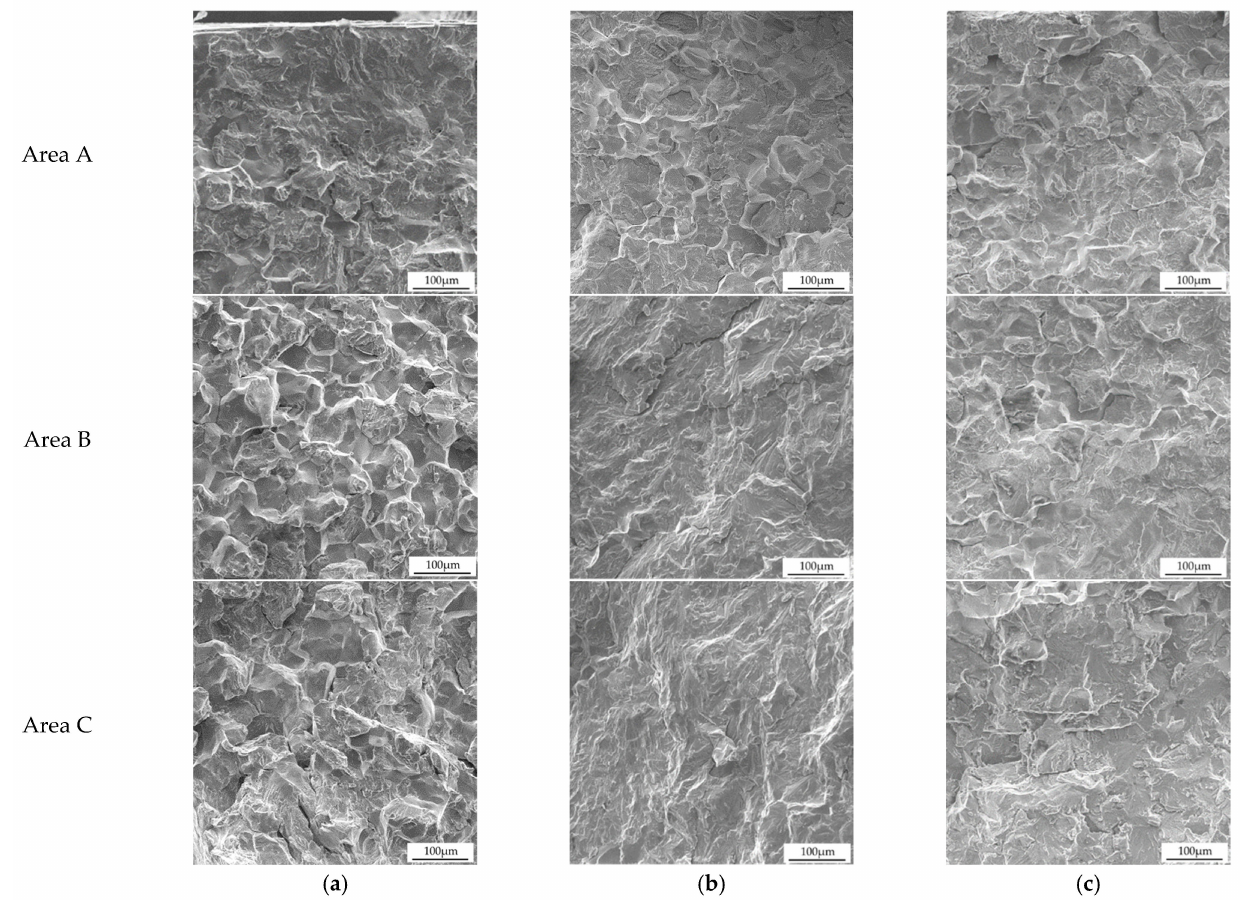
Figure 6. Cracking mode of 304LB after U-bend SCC test (SEM, × 400, 155 ◦ C, 42% MgCl 2 , top, middle, and bottom areas in Figures 5 and 6): ( a ) 304LB; ( b ) 304LB − L − NC; ( c ) 304LB − L − WC.